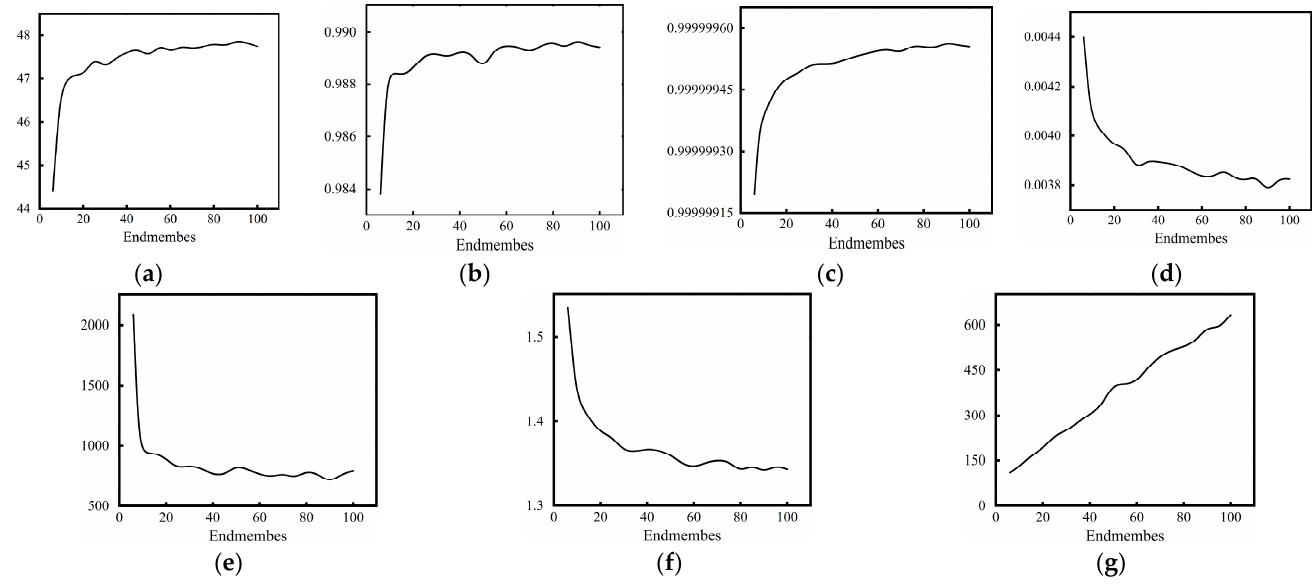
Figure 4. Effect of endmember number on the proposed method in the Hyperspec Chikusei simulated data. ( a ) MPSNR; ( b ) CC; ( c ) SSIM; ( d ) RMSE; ( e ) ERGAS; ( f ) SAM; and ( g ) TIME. Table 2. Effect of the constraints on the proposed method in the Hyperspec Chikusei simulated